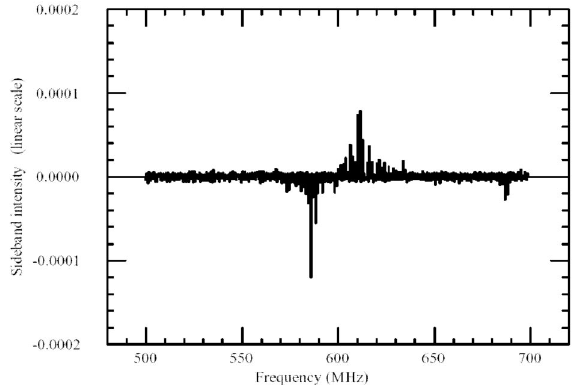
FIG. 1. The vertical betatron